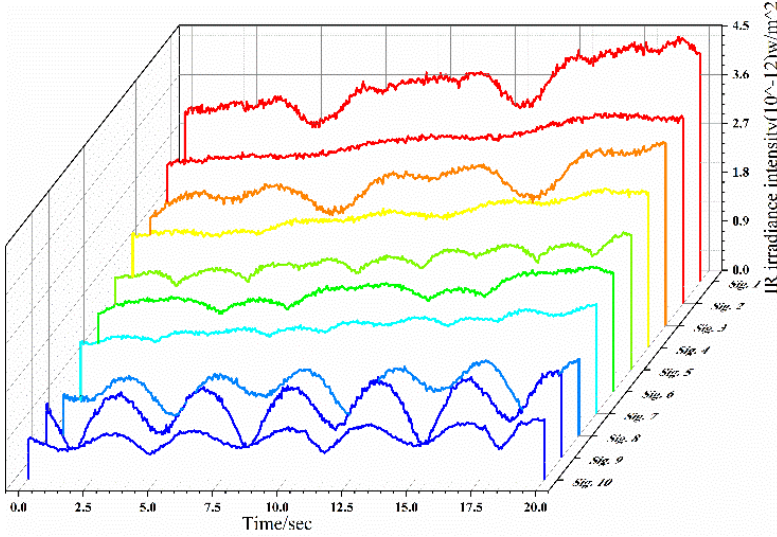
Figure 2. Infrared radiation intensity sequence of four shapes of spatial targets.